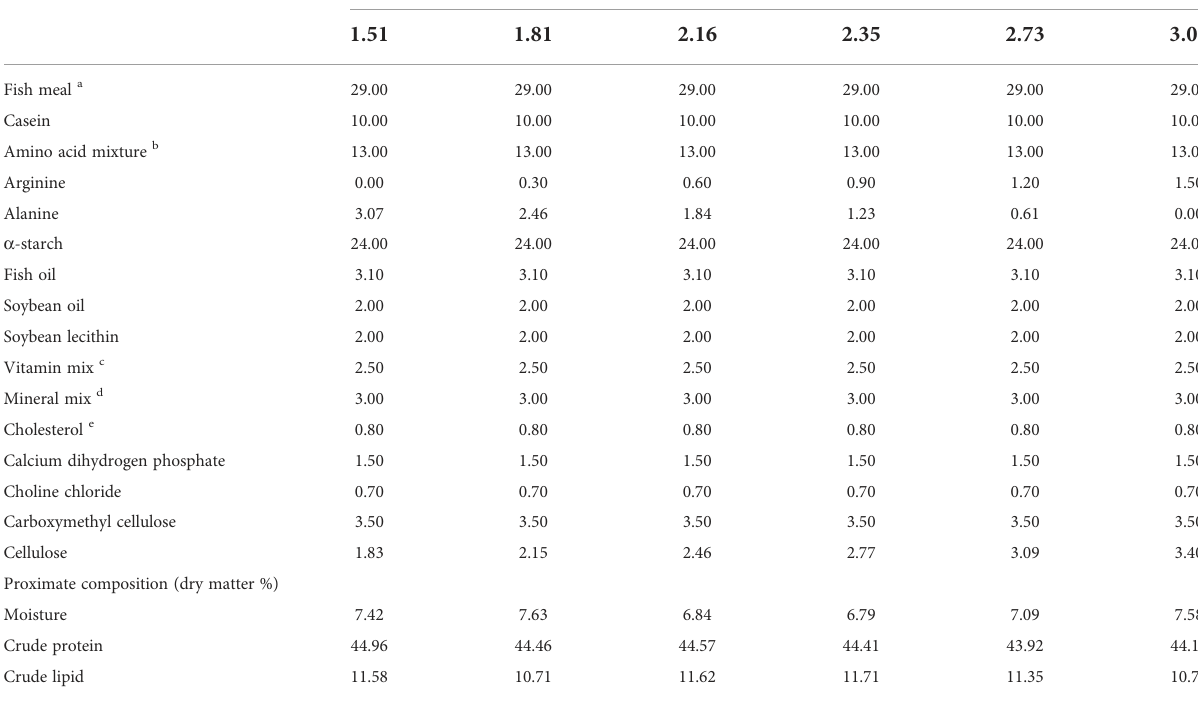
TABLE 1 Formulation and proximate composition of experimental diets (% dry